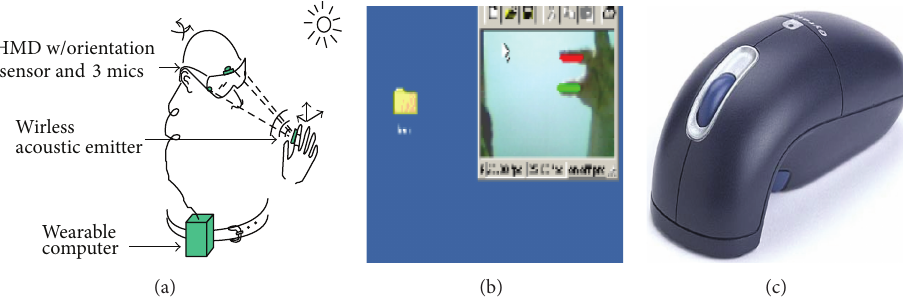
Figure 3: New wearable pointing devices. (a) Components of a WearTrack equipped wearable computer. (b) Desktop of a personal computer showing the processed camera output of the Graylevel VisualGlove . A user’s index (red) and thumb (green) fingertip positions, which control the cursor’s motion, are highlighted in color while detected by the system. (c) The Gyration Ultra GT cordless optical mouse . (a)–(c) from [17, 18, 28],